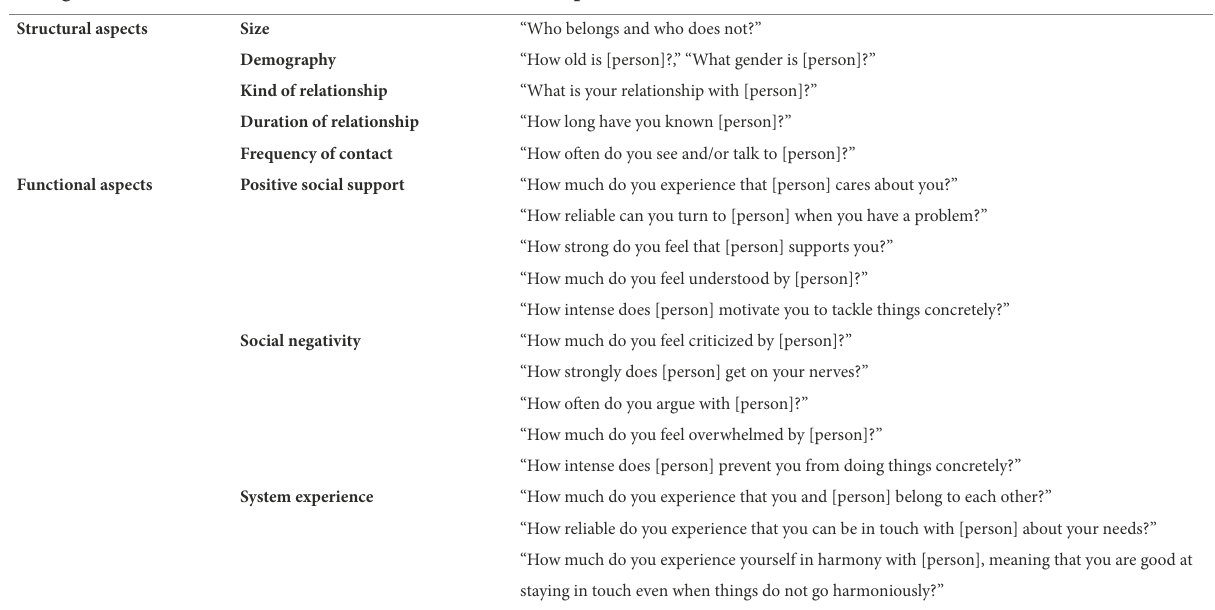
TABLE 6 Structural and functional aspects of social networks (Hunger et al.,